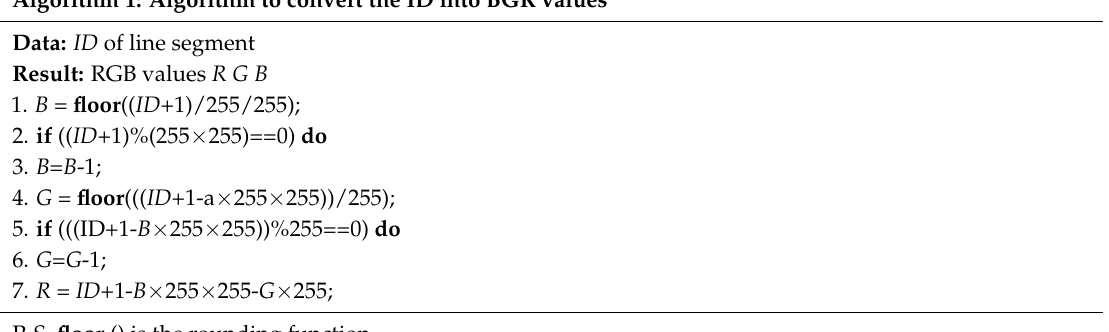
Algorithm 1: Algorithm to convert the ID into BGR values